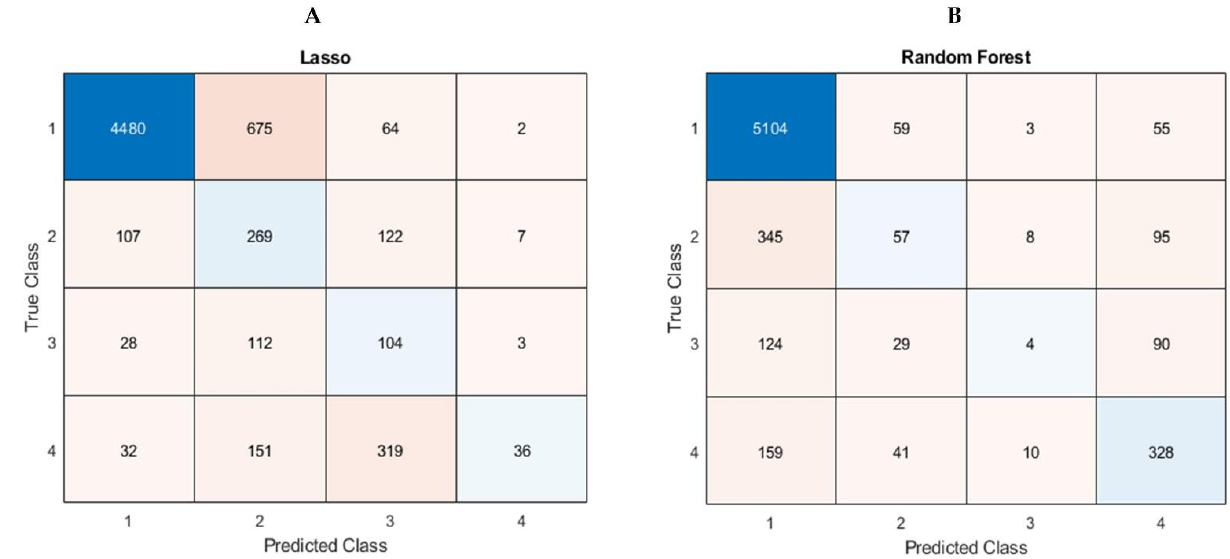
Figure 1. Confusion Matrices from LASSO ( A ) and Random Forest ( B ). Class 1 is a non-nicotine addicted group, Class 2 a lightly addicted group, Class 3 a moderately addicted group, and Class 4 a heavily addicted group. Note: Diagonal numbers from top left to bottom right are the numbers the model correctly identified a class. Table 3 is a summary of accuracy comparison based on Confusion Matrices in classes (different severity of nicotine addiction groups). Since numbers in diagonal cells in Confusion Matrices indicate correct predictions in each class, we tabulated them for accuracy comparison between two machine learning algorithms. For example, we simply divided correct prediction Table 4. Predictor variables used both by LASSO and Random Table 3. Comparison of accuracy based on Confusion Matrices (N = 6511).